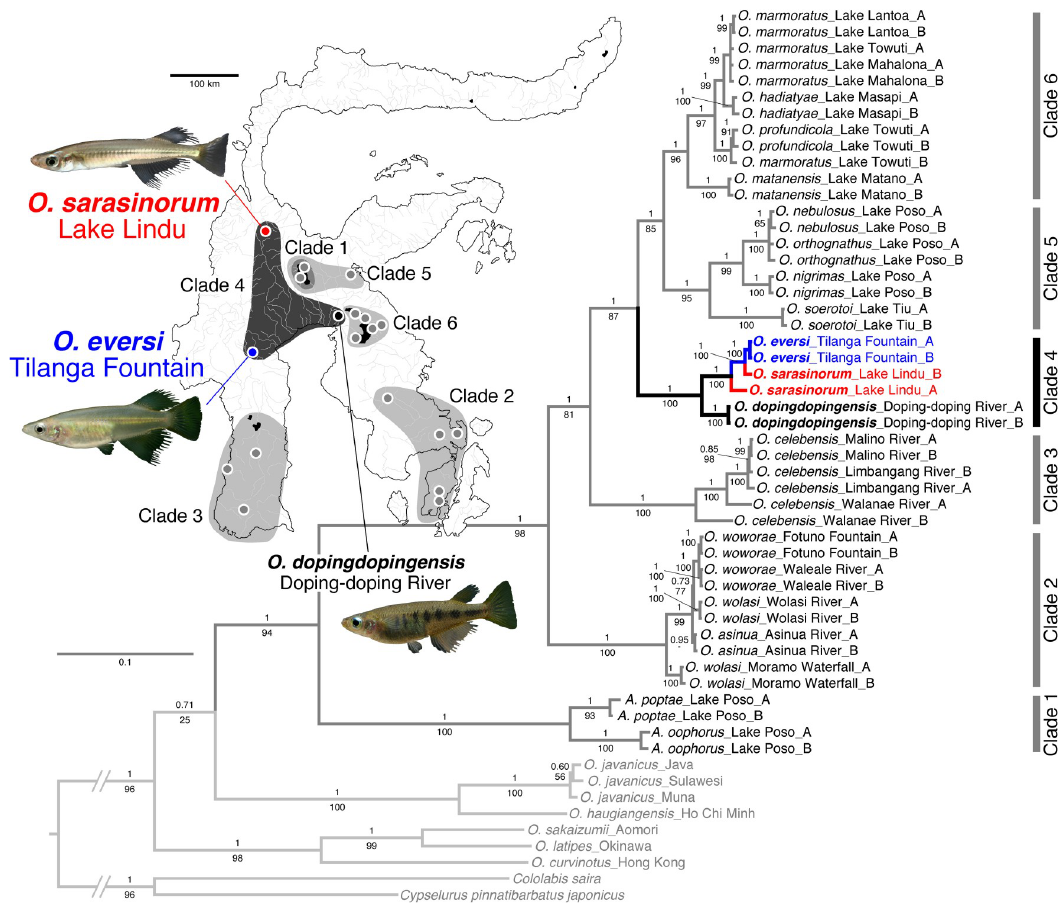
Fig 1. Mitochondrial phylogeny of Sulawesi adrianichthyids and a map of Sulawesi with the distribution of the major lineages. The mitochondrial phylogeny was based on cyt b (1,141 bp) and ND2 (1,046 bp) (modified from [15]). Note that Oryzias sarasinorum and O . eversi are endemic to Lake Lindu and Tilanga Fountain, respectively, which are approximately 190 km apart. Numbers on branches are Bayesian posterior probabilities (top) and maximum likelihood bootstrap values (bottom). The scale bar indicates the number of substitutions per